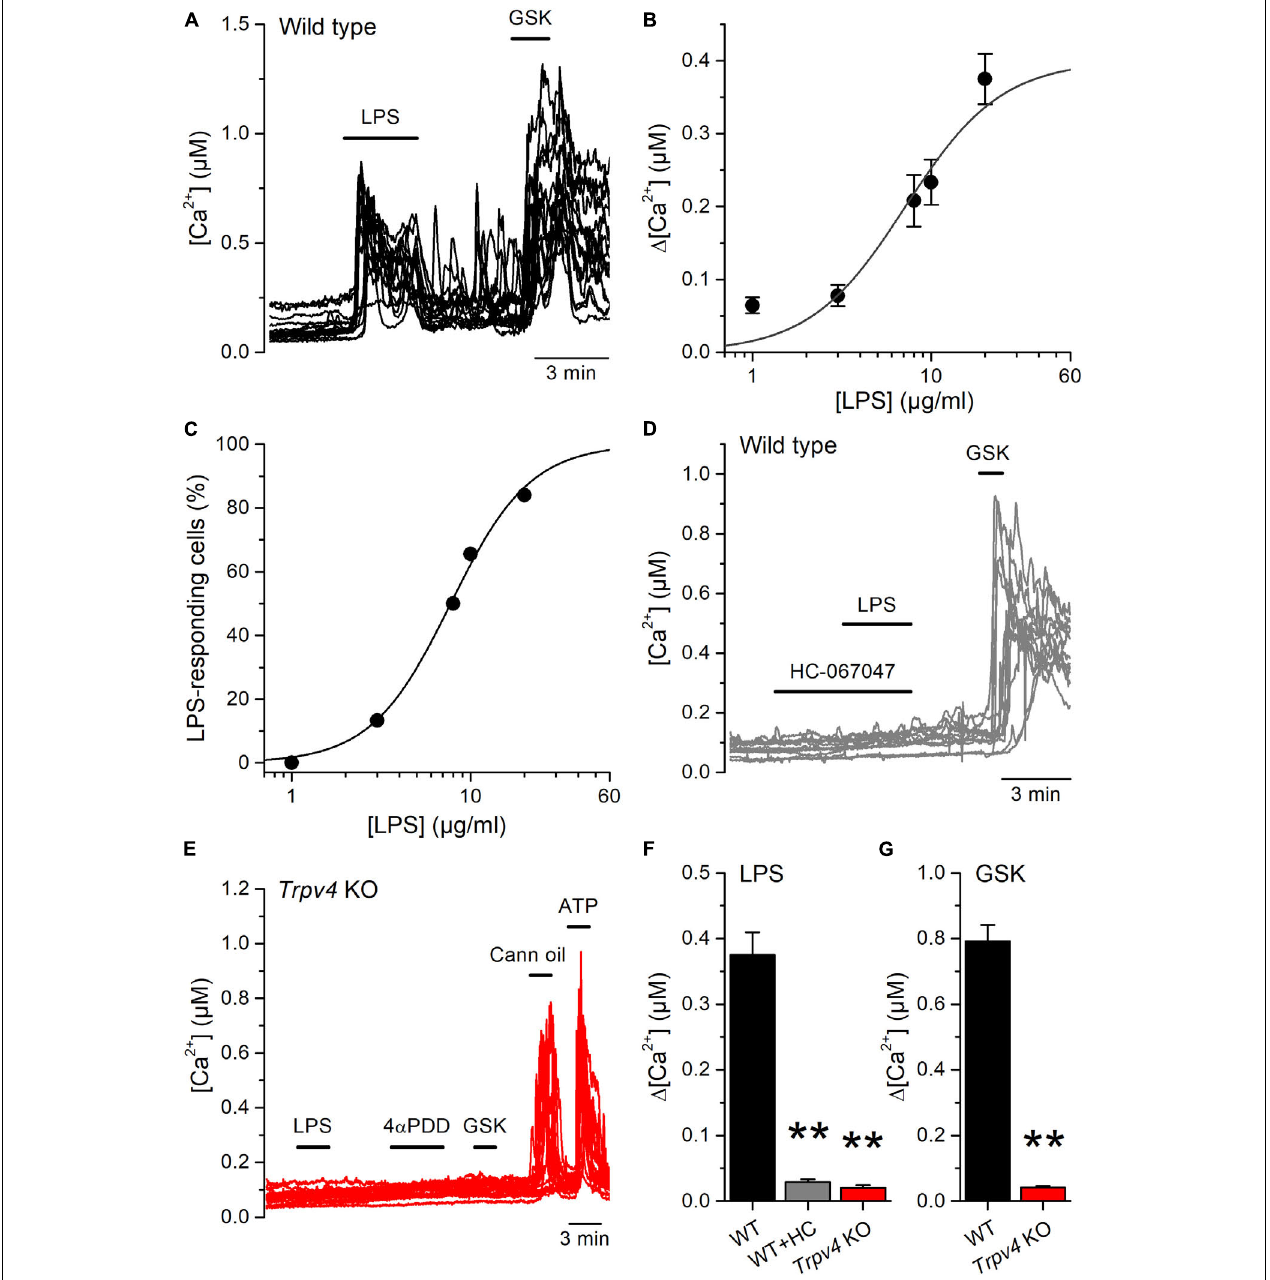
FIGURE 2 | Acute TRPV4-dependent stimulation of mouse urothelial cells by E. coli LPS. (A) Representative intracellular Ca 2 + signals recorded in urothelial cells isolated from wild type mice, showing the responses to acute application of LPS (20 µ g/ml) or GSK1016790A (GSK, 10 nM). (B,C) Concentration dependences of the amplitude (B) and percentage of occurrence (C) of LPS-evoked intracellular Ca 2 + responses in TRPV4-expressing cells (responsive to GSK1016790A 10 nM). The solid lines represent the fits with Hill equations. n > 80 cells per data point. (D) Representative intracellular Ca 2 + signals recorded in WT mUCs to which LPS (20 µ g/ml) was applied in the presence of the TRPV4 inhibitor HC-067047 (10 µ M). GSK1016790A (GSK, 10 nM) was later perfused to assess functional expression of TRPV4. (E) Representative intracellular Ca 2 + signals recorded in urothelial cells isolated from Trpv4 KO mice. LPS was applied at a concentration of 20 µ g/ml. The TRPV4 agonists 4 α PDD (2 µ M) and GSK1016790A (GSK, 10 nM) were used to evaluate the functional expression of TRPV4. A TRPV2 agonist (cannabis oil, 100 µ M) and ATP (10 µ M) were used to assess cell responsiveness. (F,G) Average amplitude of responses to LPS (20 µ g/ml) (F) and GSK1016790A (10 nM) (G) in urothelial cells isolated from wild type (WT, black bars) and Trpv4 KO (red bars) mice. HC, HC-067047 (10 µ M). The ** symbols indicate P < 0.01 with a Dunn’s multiple comparison test.